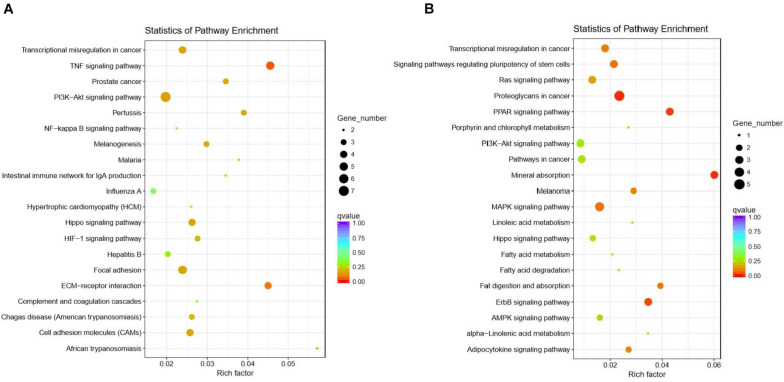
Functional annotation of the DEG genes according to the KEGG analyses. (A) KEGG enrichment analysis of the overlapping DEGs that were downregulated in the CLA + LPS group and upregulated in the LPS group. (B) KEGG enrichment analysis of the DEGs that were upregulated in the CLA + LPS group compared with the gene expression in the LPS group. Circles represent the numbers of enriched genes, and colors indicate the Padj values.